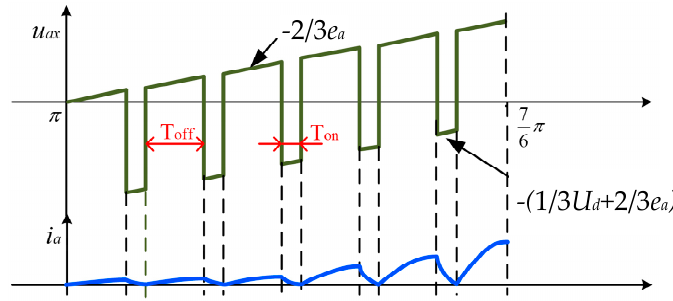
Figure 12. Voltage and current waveform of the inactive phase winding. T on and T off represent the turn-on and turn-off time of a inverter switch in one chopper period.